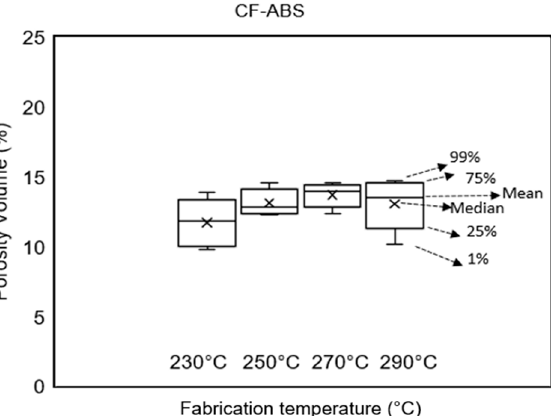
Figure 8. Fabrication temperature-influenced porosity volume in AM-fabricated CF-ABS composite .